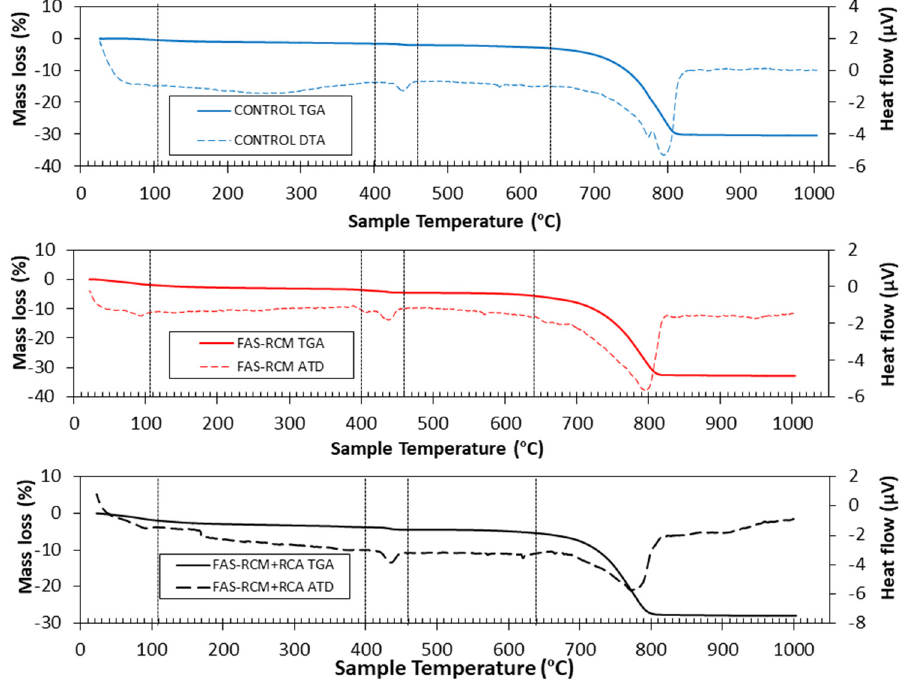
Figure 14. The TGA (solid lines) and DTA (dotted lines) for control, FAS–RCM, and FAS–RCM + RCA concrete after maturing for 28 days.